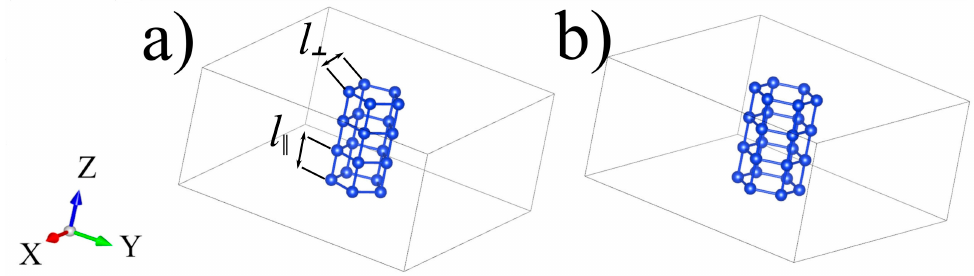
Figure 1. Supercells of silicon polyprismanes ( a ) Si 5 ( b ) and Si 6 containing four elementary cells. l ‖ and l ﬩ denote interlayer and intralayer bond lengths, respectively.